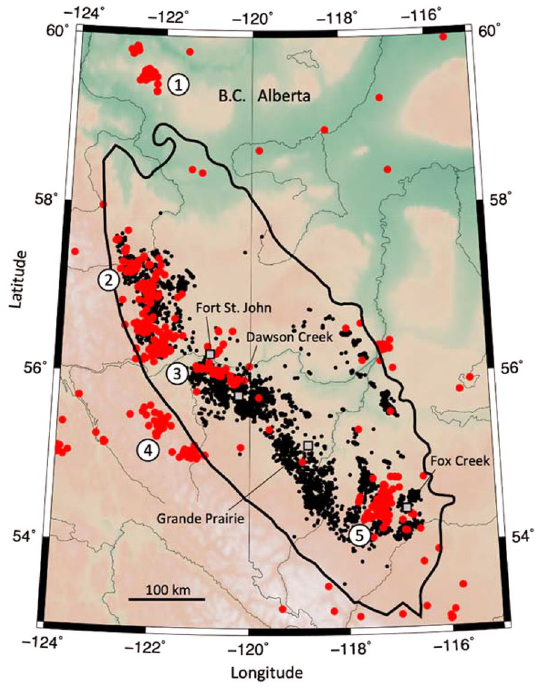
Figure 1. Regional map of seismicity and well distribution. Map of M L ≥ 2.5 seismicity (red dots) and hydraulically fractured wells completed in the Montney formation (black dots), between October 2006 to September 2017. Towns and cities are labelled, and black outline shows the extent of the Montney play. Numbers indicate seismicity clusters: 1 = Horn River Basin (HRB), 2 = northern Montney, 3 = Kiskatinaw, 4 = quarries, 5 = Fox Creek (Duvernay). In this paper, study area 1 is located north of Fort St. John, area 2 is located to the south of Fort St. John (Modified from Schultz et al. 32 . The map was created using Generic Mapping Tools (GMT) version 6 47